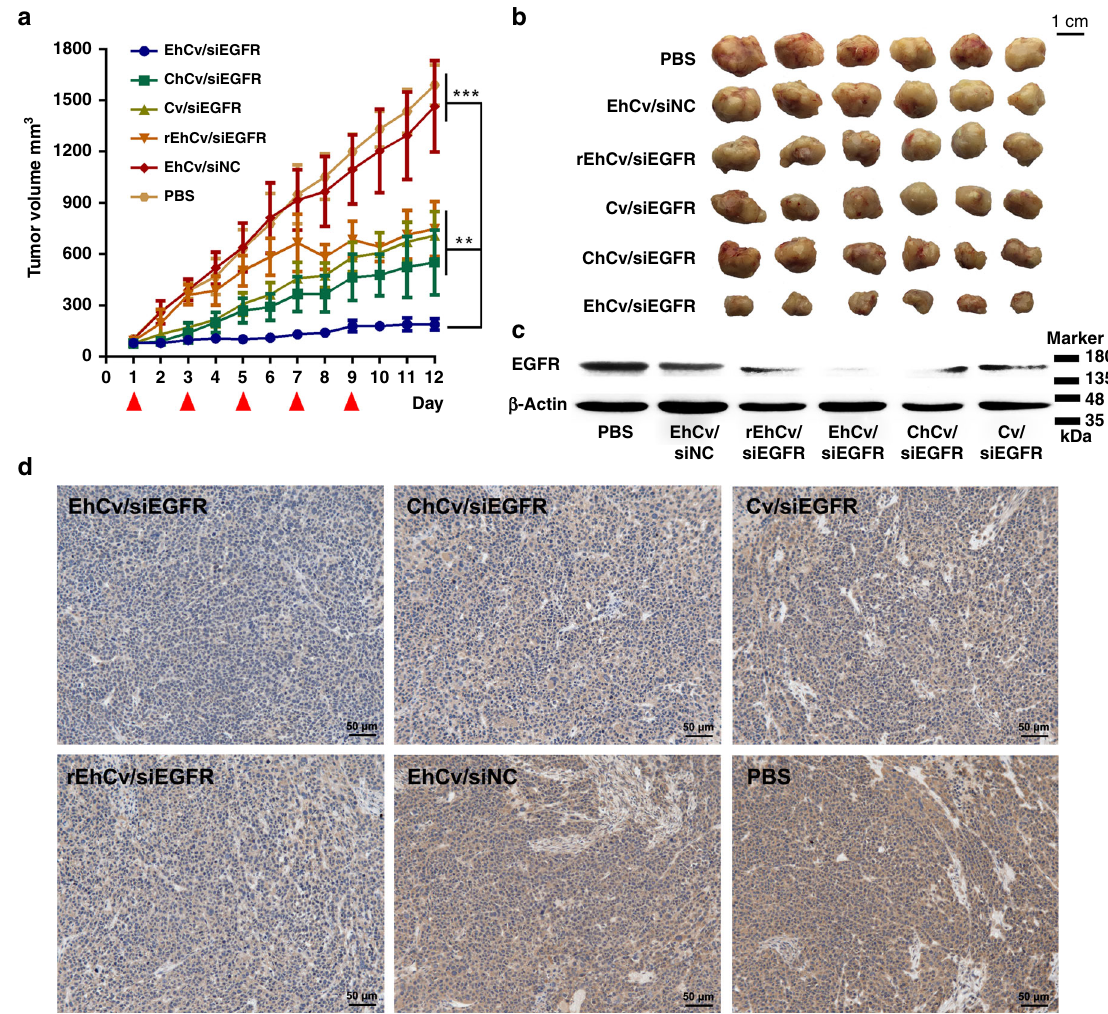
Fig. 8 In vivo tumor inhibition effects of various small interfering RNA (siRNA)-loaded nanoparticles (NPs). a Tumor growth curves of nude mice (6 mice each group) after treated by various siRNA-loaded NPs (siEGFR or siNC: 0.5 mg kg − 1 ) via peritumoral injection. Each dose was indicated by the